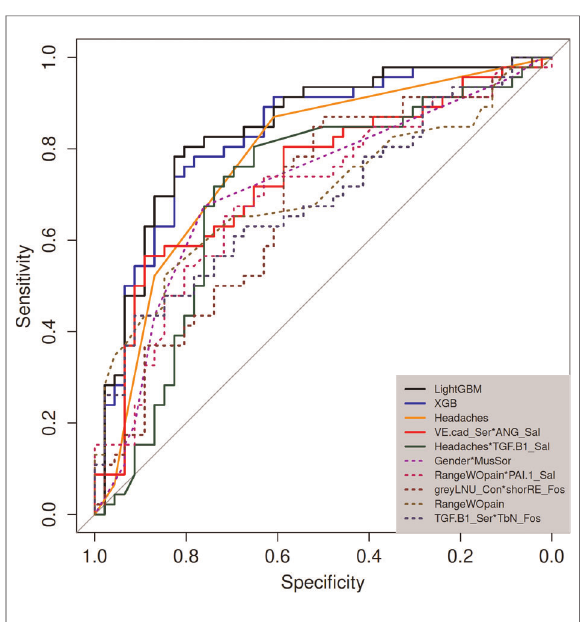
FIGURE 5 ROC curves of diagnostic sensitivity and speci fi city for individual features with top mean importance and the mean prediction of XGBoost and